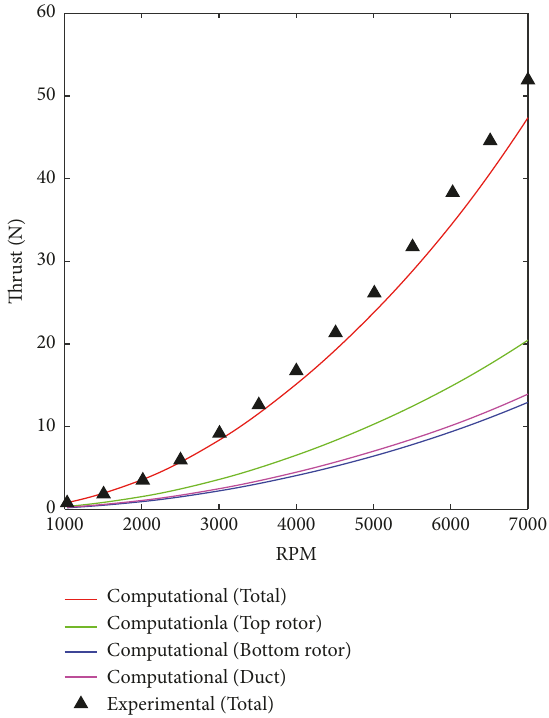
Figure 8: Hover performance comparison with experimental data at different